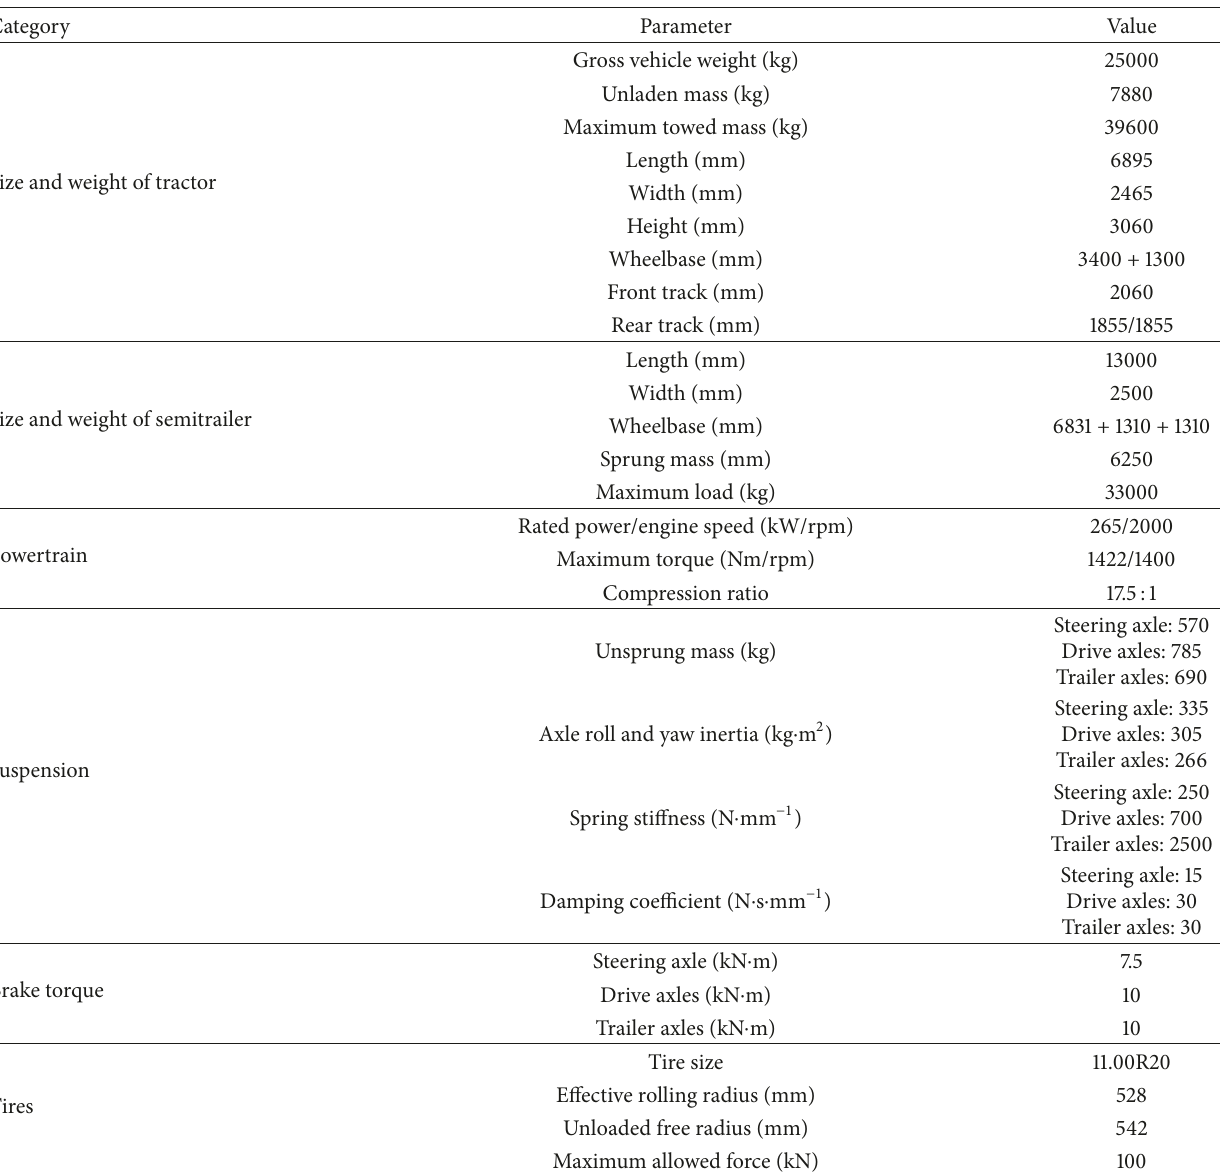
Table 1: Main parameters of tractor and